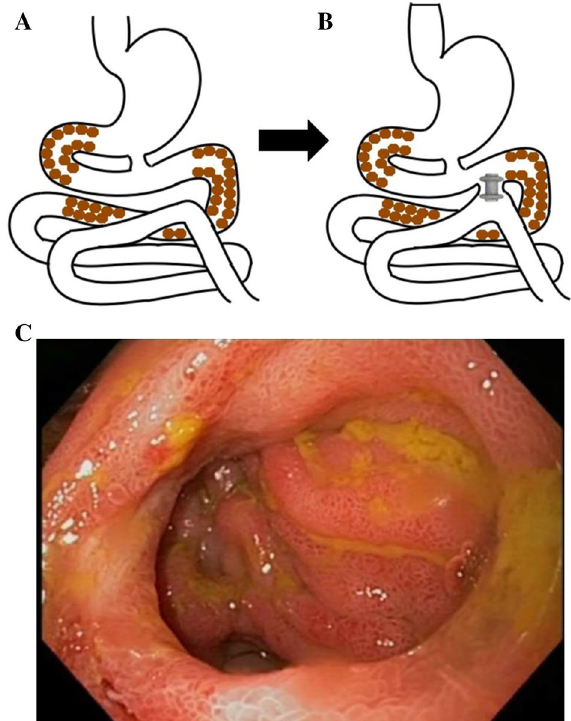
Figure 2. Graphic scheme of the patient’s anatomy ( A , left) and the site of LAMS placement ( B , right). Brown dots correspond to tumor. ( C ) Jejunal-jejunal anastomosis after removing the LAMS. Subsequent patency: 172 days (until patient